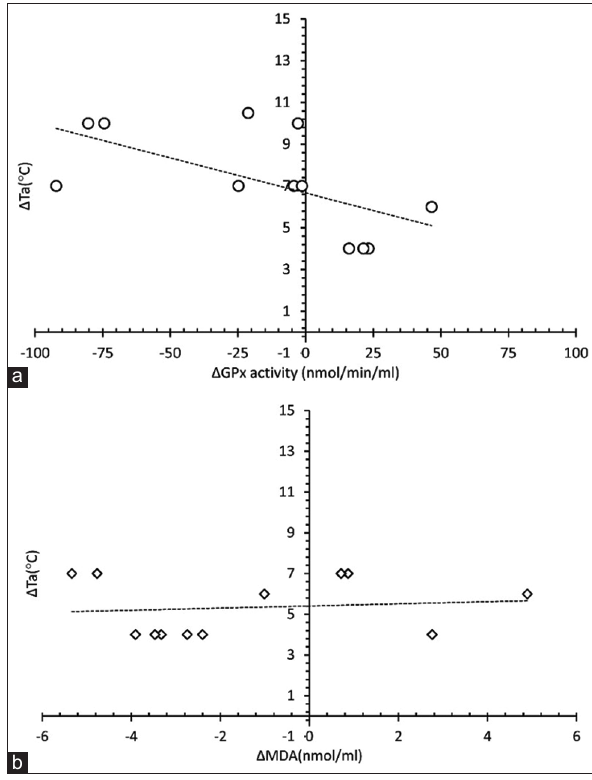
Figure-2: (a) The correlation of between a change of plasma glutathione peroxidase activity ( Δ Gpx) and (b) malondialdehyde ( Δ MDA) with Δ Ta. The significant correlation was determined using Pearson correlation (p < Table-2: The effect of natural HTa on concentration intake, roughage intake, water intake, and urine volume from D7 and D14.